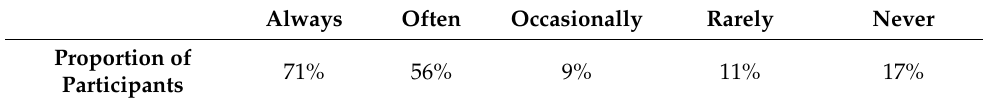
Table 4. How often you came across political content on Facebook in the last twelve months? Always Often Occasionally Rarely Never Proportion of 71% 56% 9% 11% 17% Participants A significant positive correlation was found between all the actions (Table 5). The strongest correlation, however, was found between responses to the questions “How often do you create a political content on Facebook?” and “How often do you share political content on Facebook?” (r(108) = 0.82, p < 0.01), followed by responses to the questions “How often do you read political content on Facebook?” and “How often did you see content on Facebook news media pages related to politics or political issues during the last week?” (r(108) = 0.72, p < 0.01). This finding indicates that the most active and engaged citizens are often the one who create, share, see and read political content on Facebook. This demonstrates that social media contribute to high-level engagement in various political activities